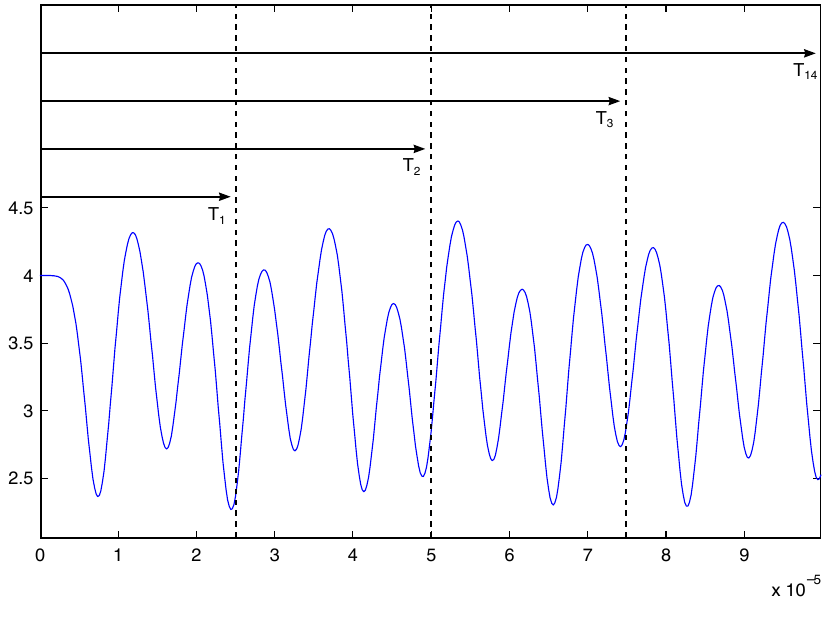
Figure 9. Computational experiment (iii) divided into time intervals (T1), (T2), (T3), (T4).